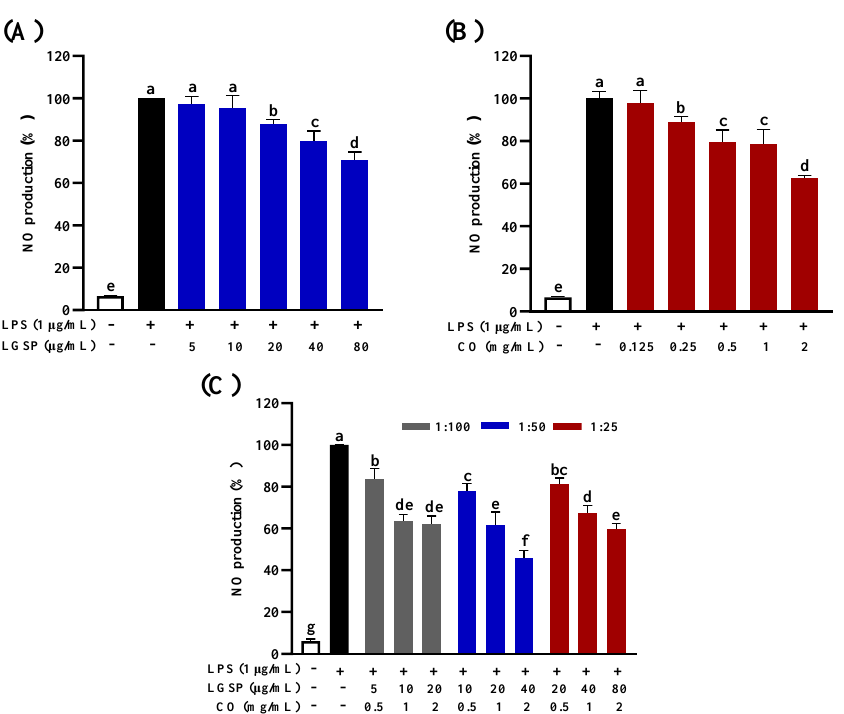
Figure 2. Effect of LGSP ( A ), CO ( B ) and their combination ( C ) on NO production in RAW264.7 cells. All values are means ± SD, n = 3. Different letters above the bars indicate significant differences ( p < 0.05).